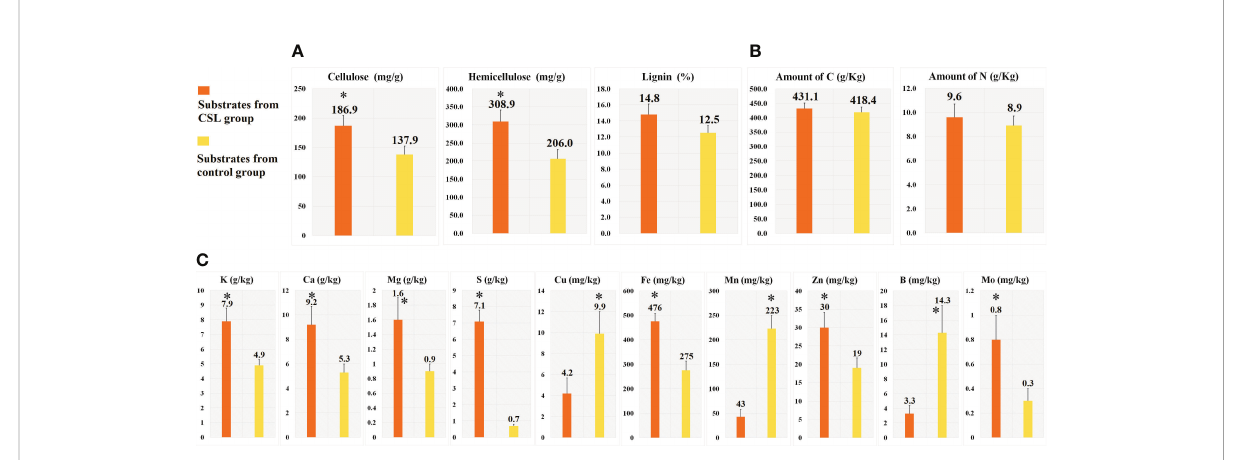
FIGURE 2 Chemical analyses of the substrates. cellulose, hemicellulose and lignin (A) , macronutrients (B) and micronutrients (C) . *, Statistically signi fi cant p <